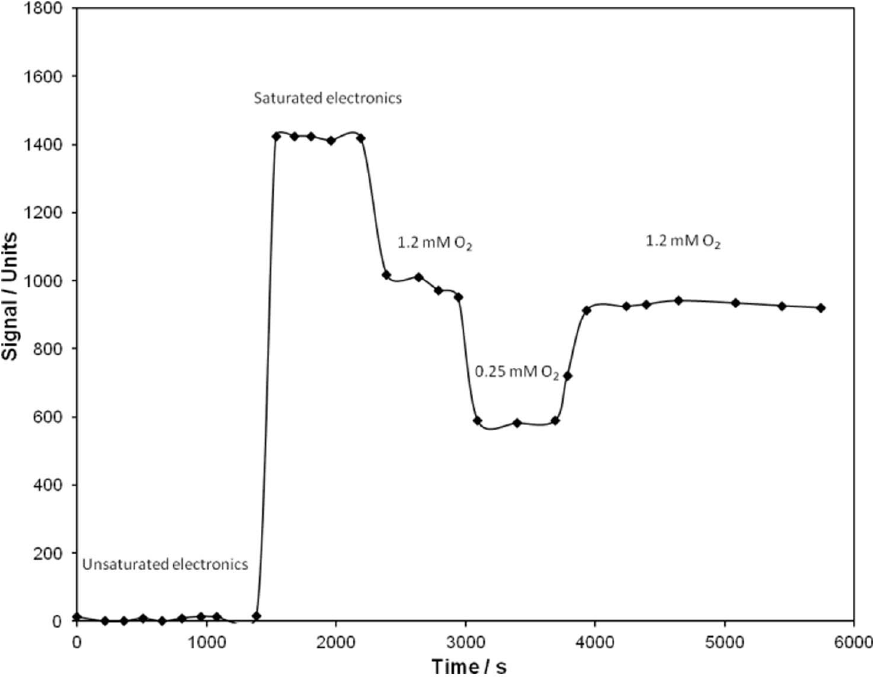
Figure 4. Wireless oxygen sensing. Recorded signal from the self-contained biodevice for oxygen monitoring in buffers with varying oxygen concentrations.